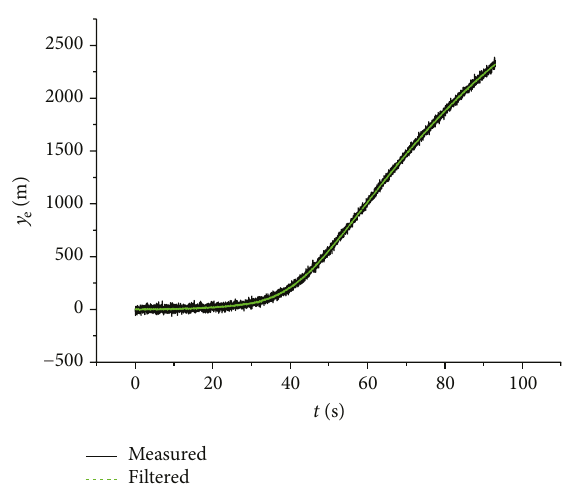
comparison fi gure. e